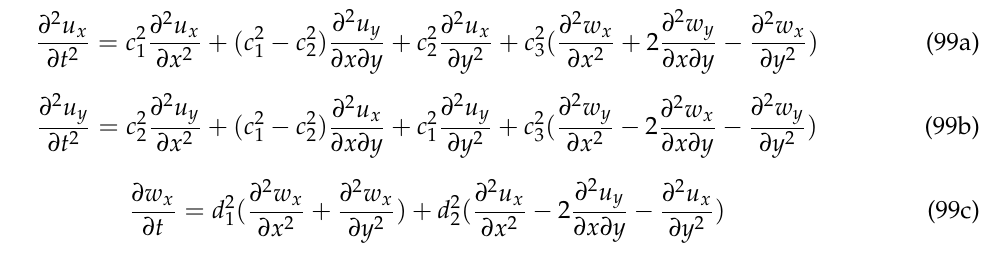
Figure 6. Variations of w z / b 3